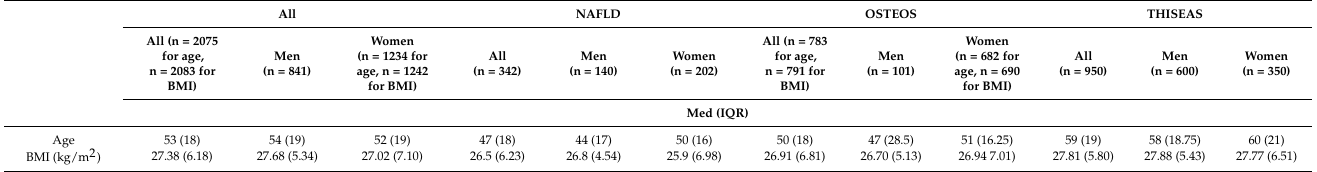
Table 1. Descriptive characteristics of the NAFLD, OSTEOS and THISEAS study populations.